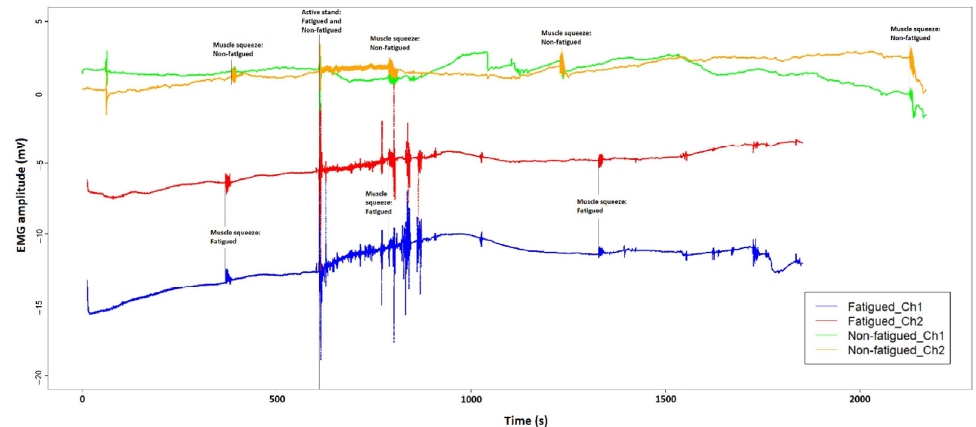
Figure 6. Surface EMG signals of the left vastus lateralis (shown as Ch1) and the left rectus femoris (shown as Ch2) of a fatigued participant, compared with a participant who did not report fatigue as part of the long COVID symptomatology. Thigh muscle contractions that were captured during the two recording sessions are marked by black vertical lines with corresponding annotations. The two data frames are synced at the onset of the active stand test at approximately 600 s.